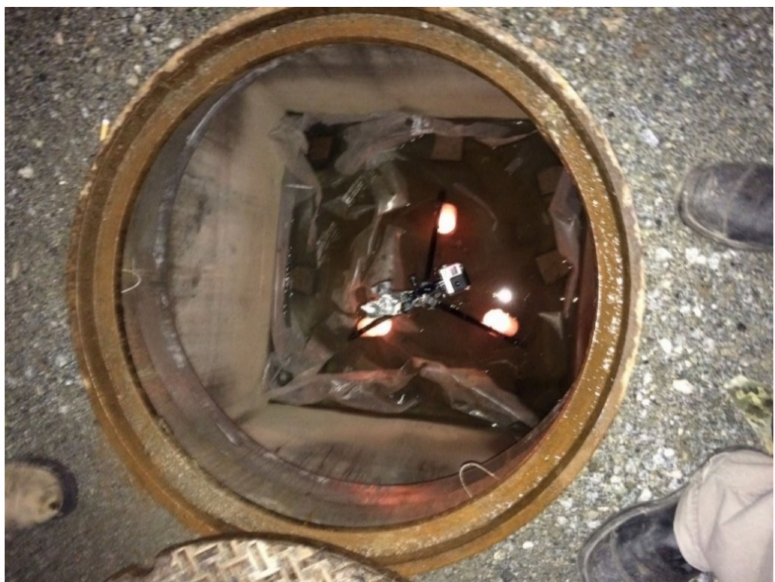
Figure 2. Interior view of the isolated subsurface structure showing the stand holding the cameras. The GoPro camera is clearly visible. The lighting configuration was an early version. This version provided insufficient illumination for obtaining